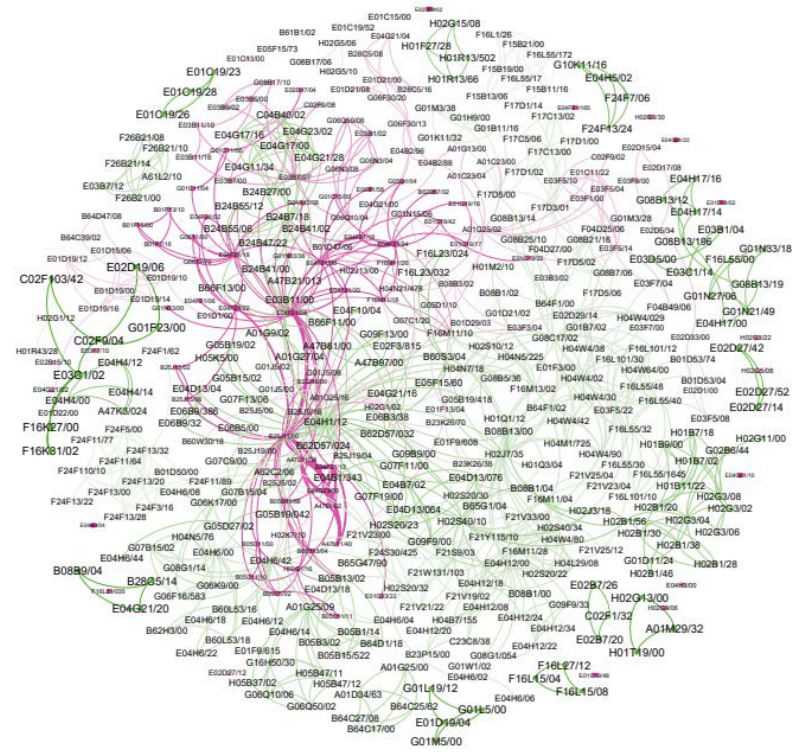
Figure 9. Digital construction innovation network (2019).